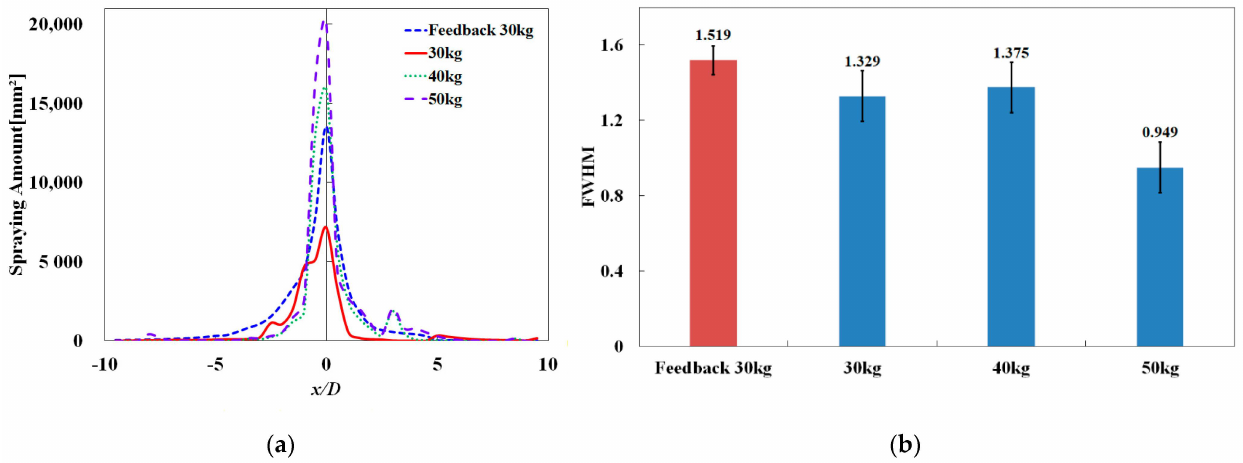
Figure 15. ( a ) Variations of spraying amount along the radial position and ( b ) corresponding FWHM for the non-feedback nozzle.